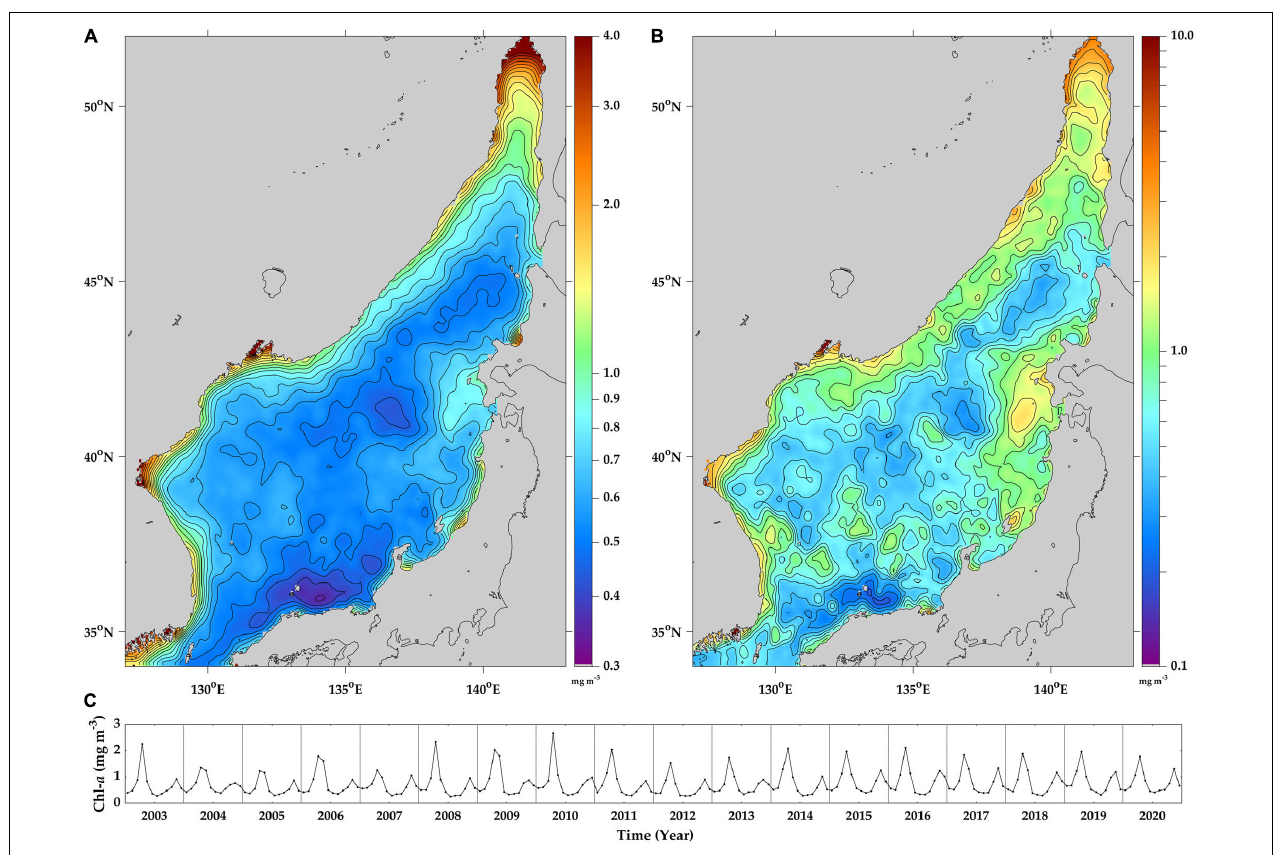
FIGURE 3 | Spatial distributions of (A) temporal means, (B) temporal standard deviations, and (C) time series of spatial means of MODIS chlorophyll- a concentration in the East Sea (Sea of Japan) between 2003 and